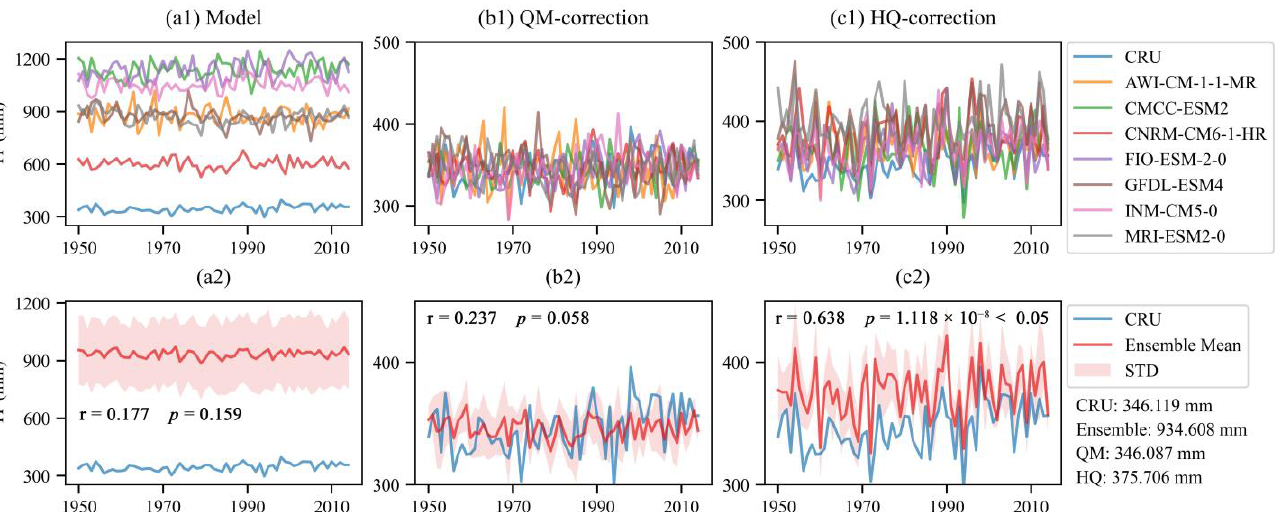
Figure 3. Standardized Taylor diagrams of precipitation and PET. ( a1 , a2 ): uncorrected CMIP6 model simulation precipitation and PET. ( b1 , b2 ): the result of quantile mapping (QM) correction. ( c1 , c2 ): the result of HQ correction. The correlation coefficients, standard deviation, and root mean square error are the mean of all pixels across QHTP.